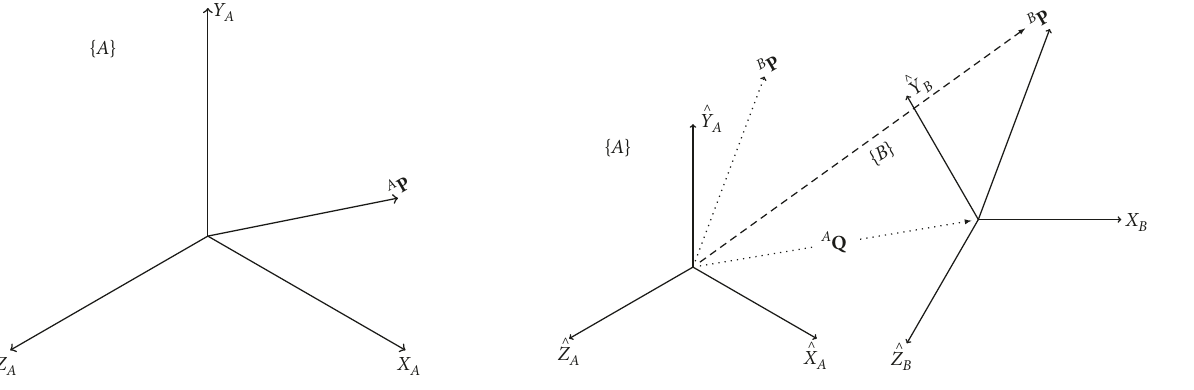
Figure 1: Vector related to the plane A { } .